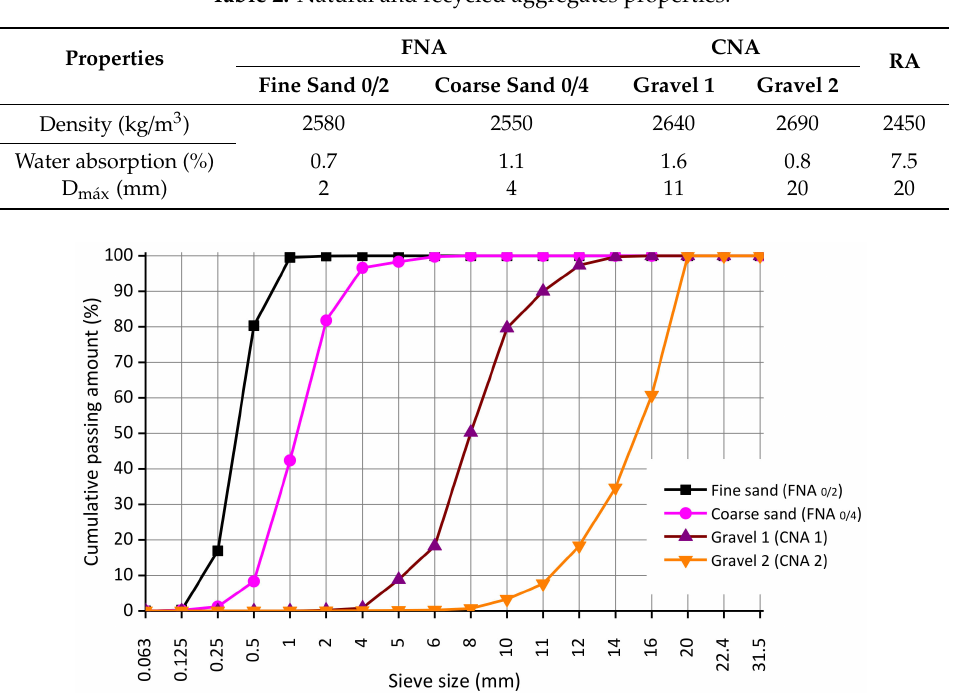
Table 2. Natural and recycled aggregates properties.